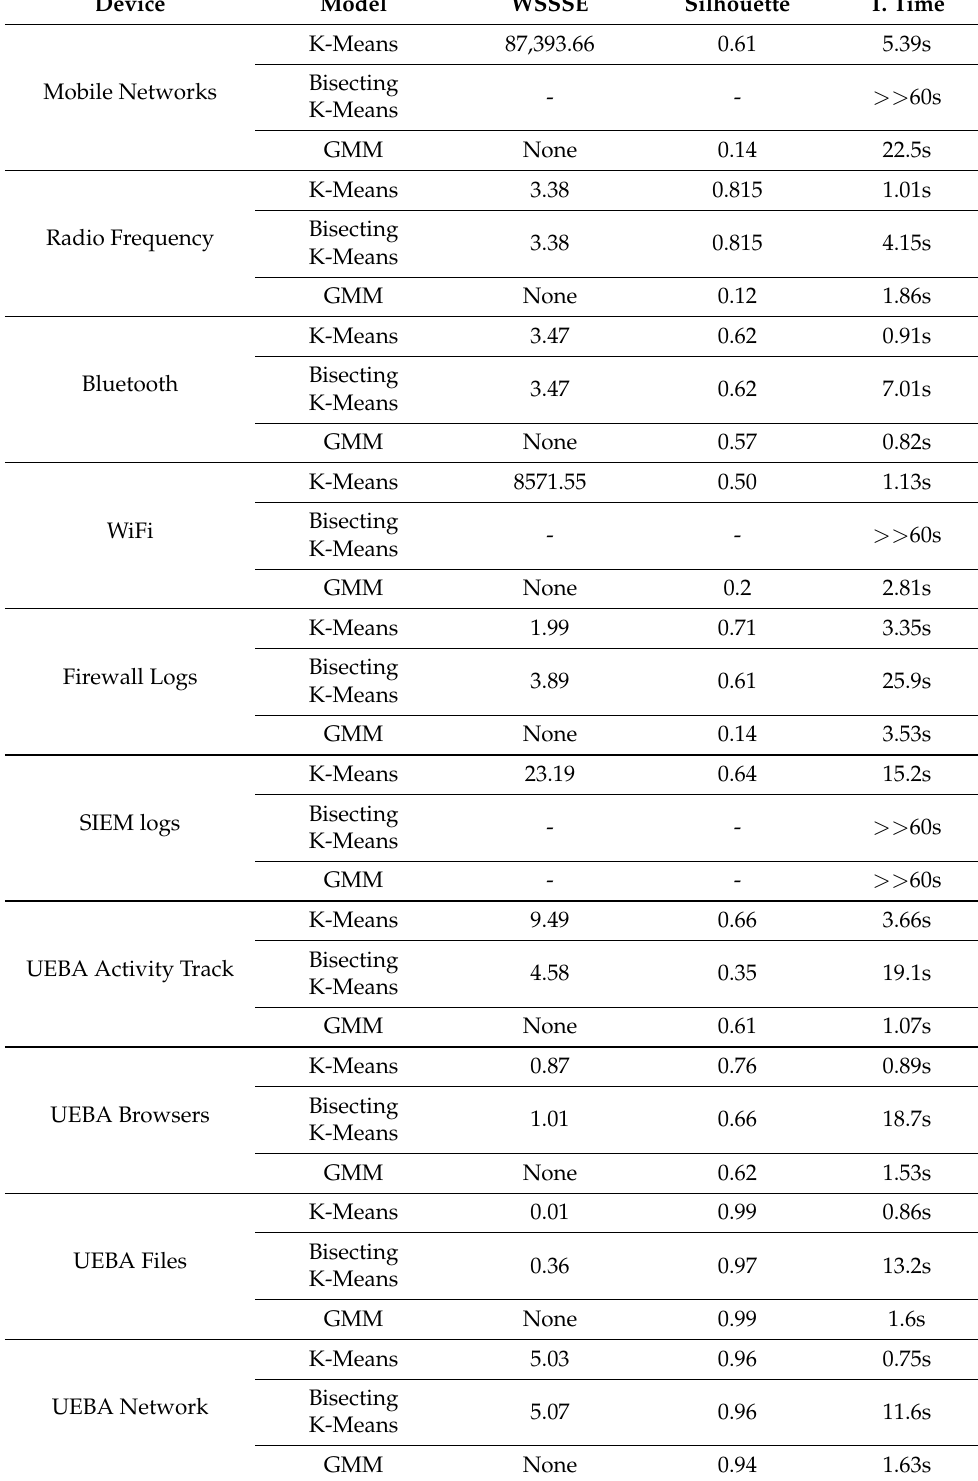
Table 3. Comparison of the different models for each